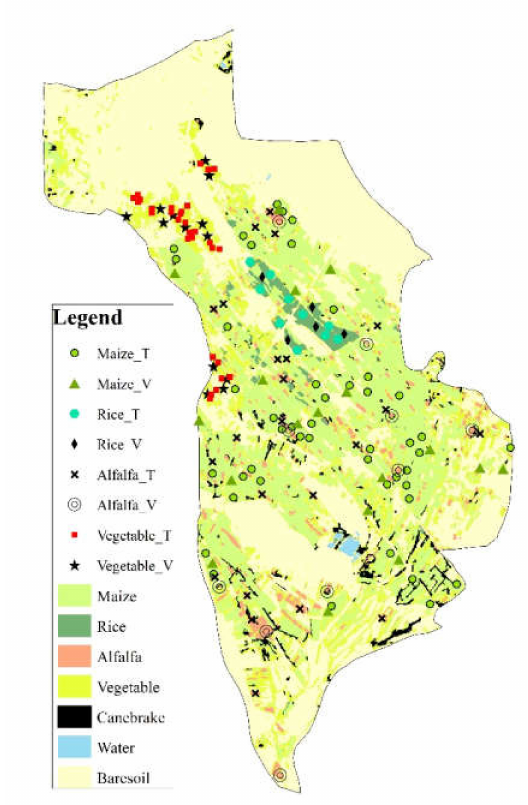
Figure 8. Crop mapping of the study area using the classification-feature selection ensemble procedure and the spatial distribution of training (T) and validation (V) samples of